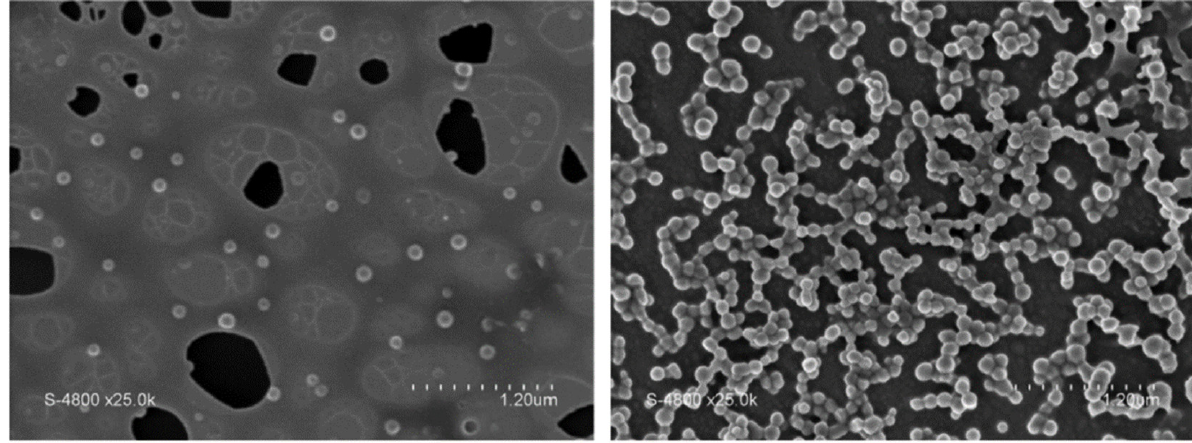
Figure 18. Scanning electron microscopy (SEM) micrographs of nanosized AB, dropped onto a carbon film on a cooper grid. Reprinted with permission from [306]. Copyright (2019), American Chemical Society.